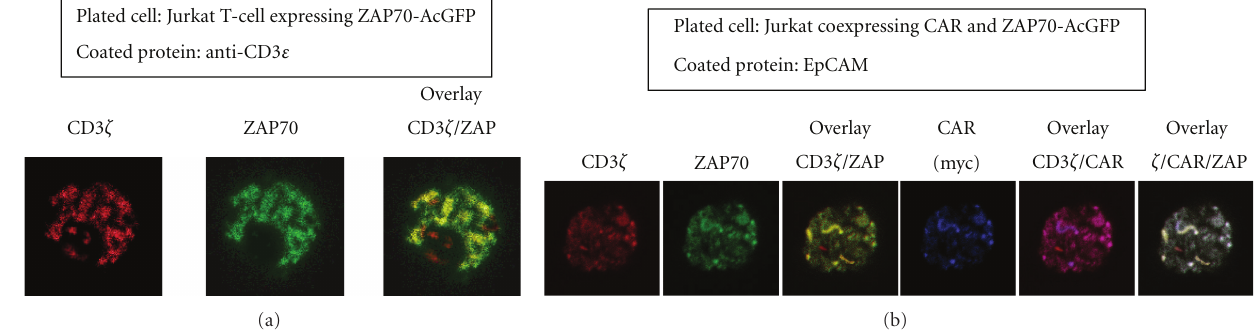
Figure 6: The formation of the signaling clusters in CAR-expressing cells by antigen stimulation. Jurkat cells expressing ZAP-70-AcGFP were plated on stimulatory coverslips coated with anti-CD3 ε , then fixed and stained with fluorescently-labeled anti-CD3 ζ . Confocal images at the interface between the attached cells and the stimulatory surface were collected (a). Jurkat cells coexpressing ZAP-70-AcGFP and CAR57-28 ζ were plated onto EpCAM-coated coverslips and stained with anti-myc and Alexa-labeled anti-CD3 ζ antibodies, as described in Section 2 (b).